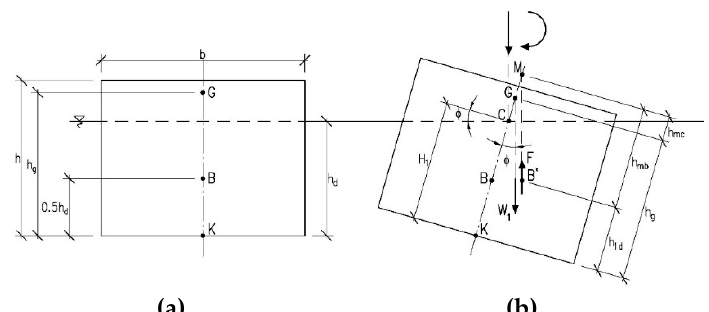
Figure 2. The schematic drawing of the pontoon under constant load ( a ) and the schematic draw- ing of the pontoon under constant and variable load ( b ), where G—gravity centre of the pontoon, B—buoyancy centre of the pontoon at rest, K—keel, h d —immersion due to the dead weight load, h g —location of the gravity centre, C—centre of the visible area of the water surface, M—metacentre, W 1 —total weight of constant and variable loads, B’—buoyancy centre of the loaded pontoon, F—floating forces in water, h mc —metacentric height above the gravity centre, h mb —metacentric height above the buoyancy centre, and h 1d —height of the buoyancy centre.